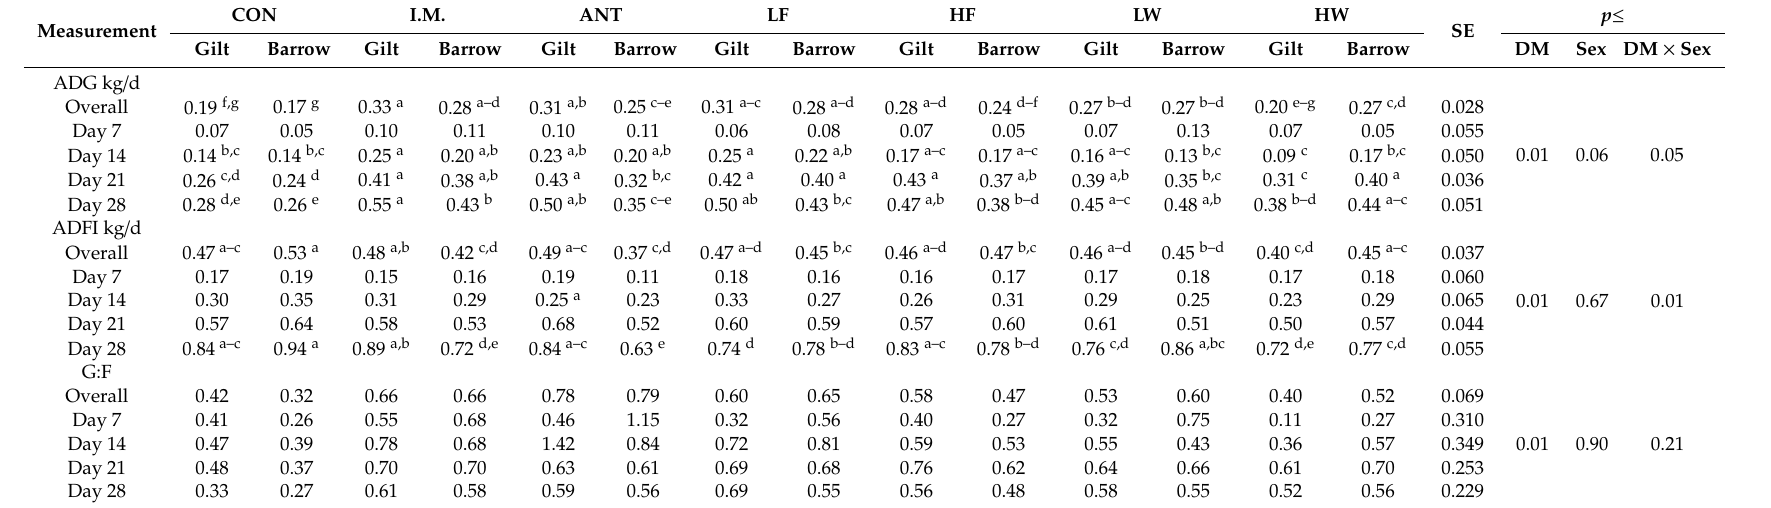
Table 2. Impact of treatment and sex on various growth performance variables.